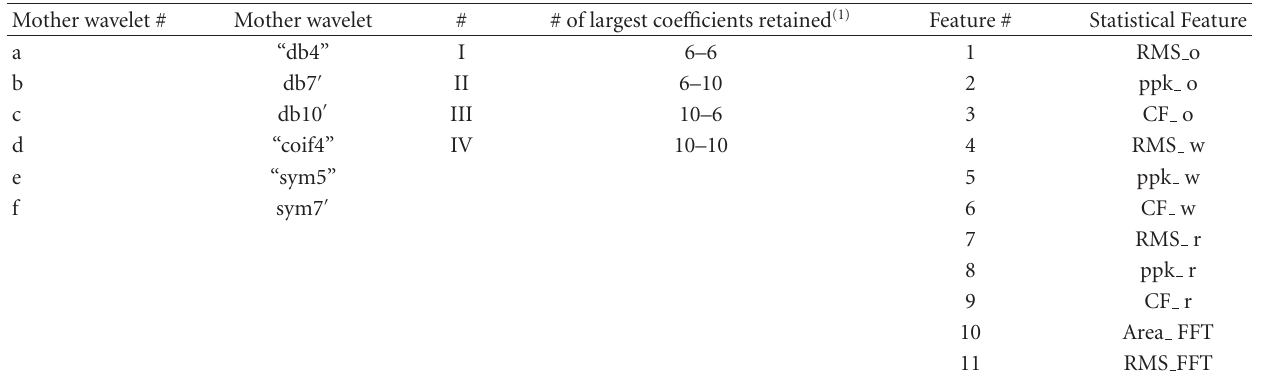
Table 2: Mother wavelet, number of largest wavelet coe ffi cients, and statistical features considered in the rail head algorithm monitoring